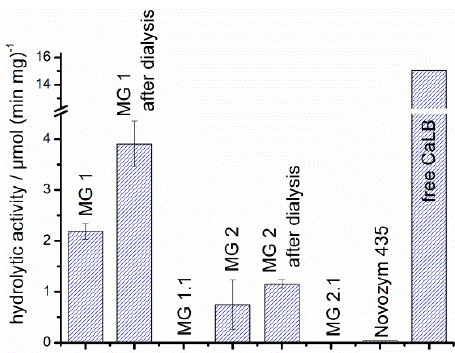
Figure 6. Hydrolytic activity of the CaLB loaded microgels MG 1 and MG 2 before and after dialysis (MWCO 100 kDa) and the CaLB-free microgels MG 1.1 and MG 2.1 as well as the non-immobilized CaLB as reference.